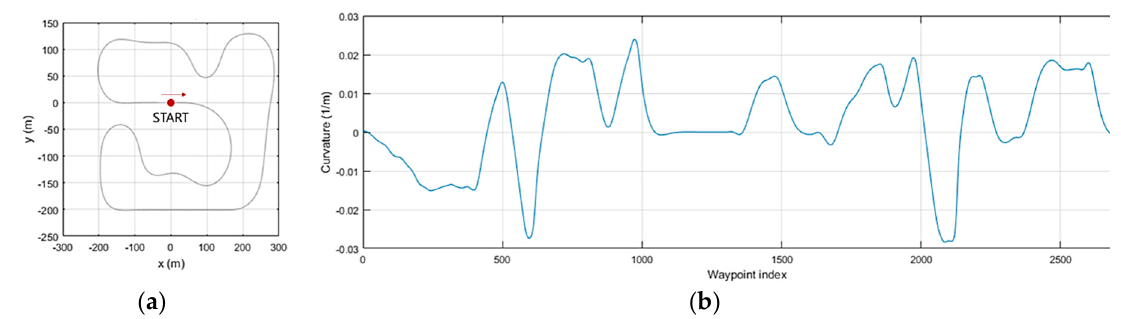
Figure 7. ( a ) Reference path and ( b ) curvature information which had been calculated with regular intervals by 0.8 m for the SIL test.